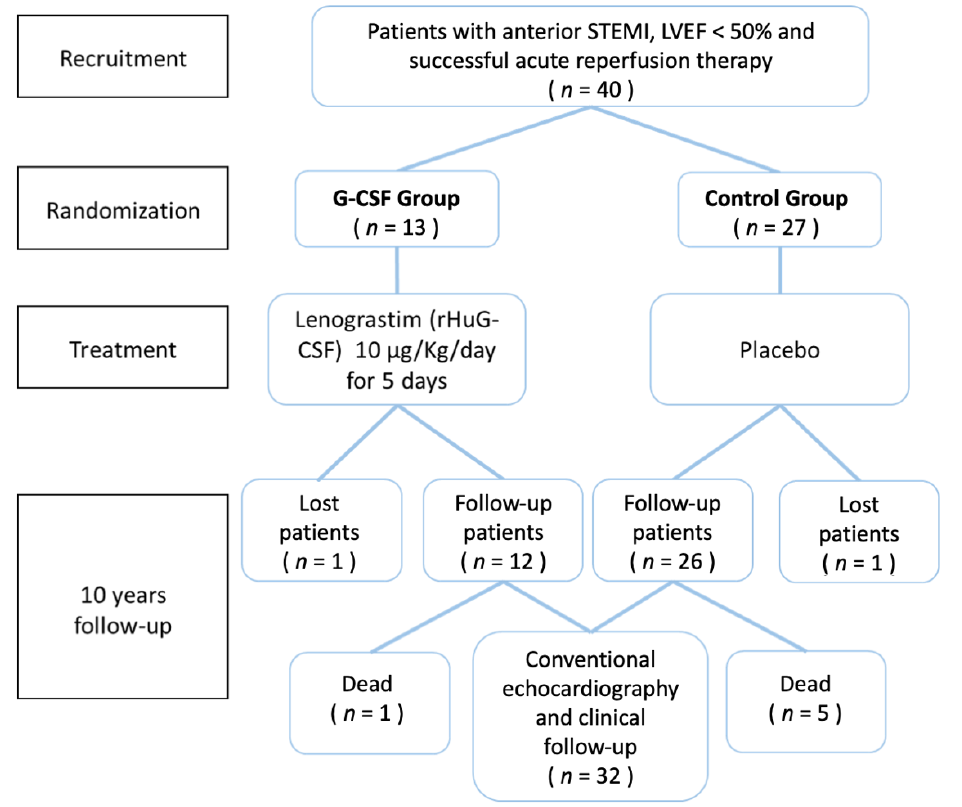
Figure 1. Overview of the study protocol, which shows the different phases of design, enrollment and treatment procedure of RIGENERA study and respective 10-year follow-up.